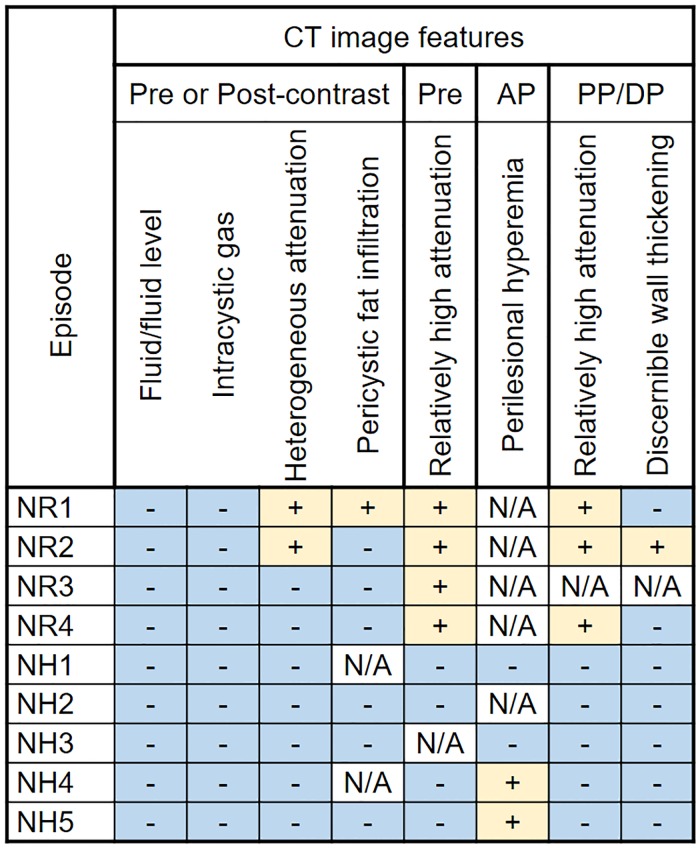
Mapping for CT imaging features in 9 episodes of noninfected cysts in 9 patients with ADPKD.Note: ADPKD = autosomal dominant polycystic kidney disease; Pre = pre-contrast images; AP = arterial phase images; PP = portal venous phase images; DP = delayed phase images; NR = noninfected renal cyst; NH = noninfected hepatic cyst.